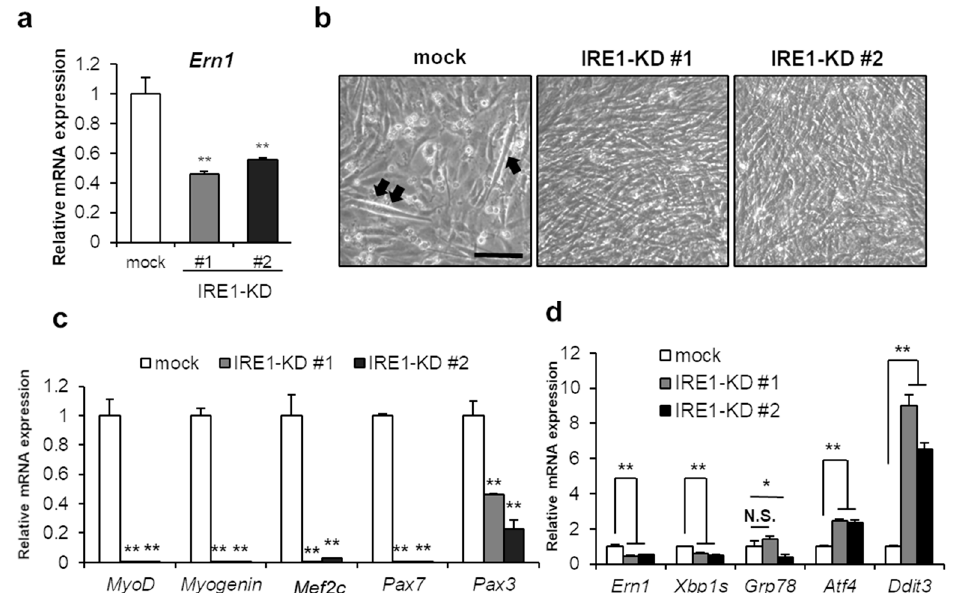
Figure 1. IRE1 is required in C2C12 differentiation. ( a ) IRE1-knockdown cell lines #1, #2, and mock cells were evaluated for the expression of IRE1/ Ern1 mRNA. Results are means + SEM (three biological replicates). ** p < 0.01. ( b ) Differentiation was induced in IRE1-knockdown cell lines and mock cells. After 48 h, cells were observed under phase contrast. Black arrows show the immature myotubes. Scale bar = 100 µm. ( c , d ) Cells were harvested after differentiation induction at 48 h. mRNA expression of myogenic factors ( c ) and UPR relative factors ( d ) was analyzed by qPCR. Results are means + SEM (three biological replicates). * p < 0.05, ** p < 0.01.